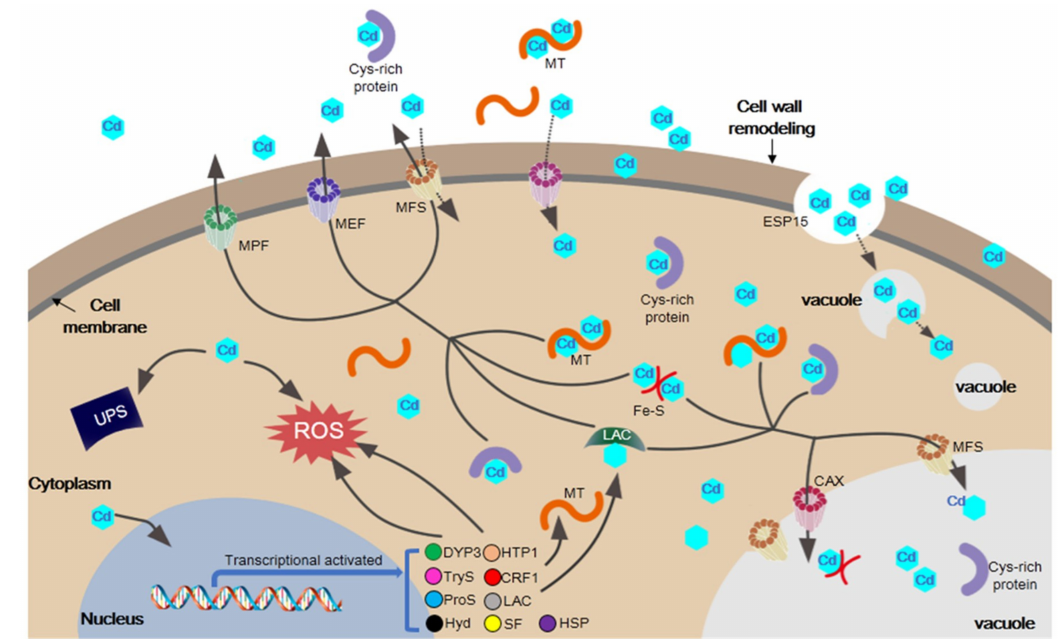
Figure 6. The schematic map of cellular response by Pleurotus ostreatus under Cd stress. Cd could be absorbed onto the surface of cell walls. Lots of Cd could be transported into cytoplasm by Transporters or Endocytosis (EPS15). Cysteine rich protein (Cyc-rich protein), Fe-S cluster (Fe-S), metallothionein (MT) and laccase (LAC) chelated Cd, and the metal chelation could be transported extracellular or into vacuole by membrane transporter metal-phosphate complexes efflux (MPE), Mate efflux family (MEF), major facilitator Superfamily (MFS) and Ca( 2+ )/H( + ) exchange (CAX). Reactive Oxygen Species (ROS) and ubiquitin-proteasome system (UPS) can be activated by heavy metals and some antioxidase such as DyP-type peroxidase (DYP3), heme-thiolate peroxidase (HTP1) could be induced. Copper resistance protein CRF1, a copper binding transcription factor, is more sensitive to Cd but not to other metals and would activate late metallothionein (MT) transcription directly. Macrofungi detoxify also by synthesis tryptophan (TryS) and proline (ProS), hydrophobin (Hyd), heat shock protein (HSP) and stress-inducible protein